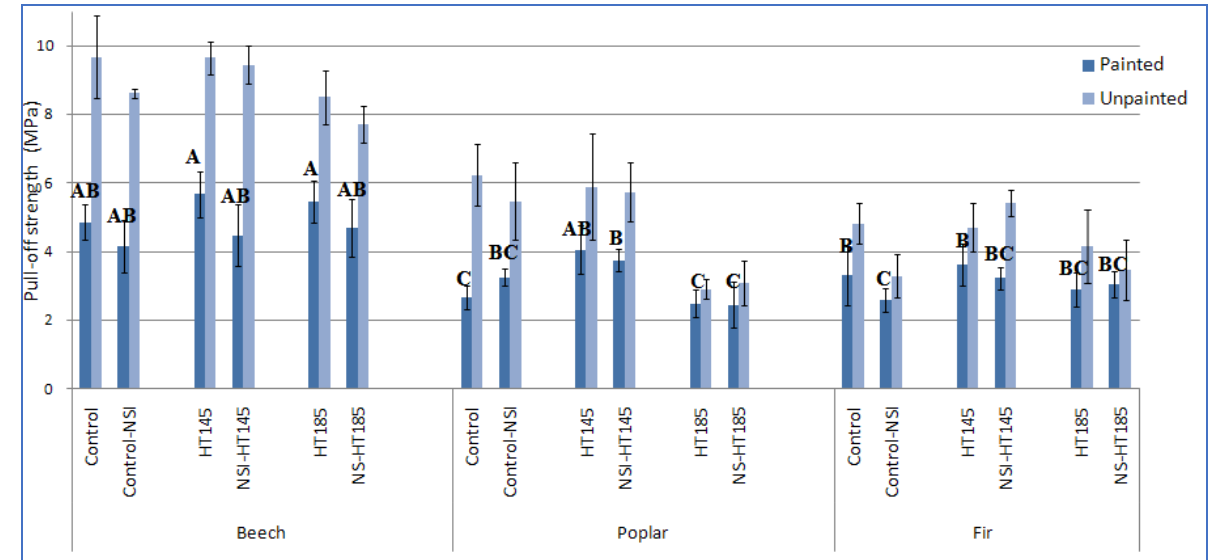
Figure 3. Pull-off adhesion strength (MPa) of the three species (beech, poplar, and fir) painted with sealer–clear finish and unpainted, letters in each column represent Duncan’s multiple range test, at 95% level of confidence ( α = 0.05) based on the painted treatments (NSI = nanosilver-impregnated; HT = heat-treated at the specific temperature of either 145 or 185 °C).